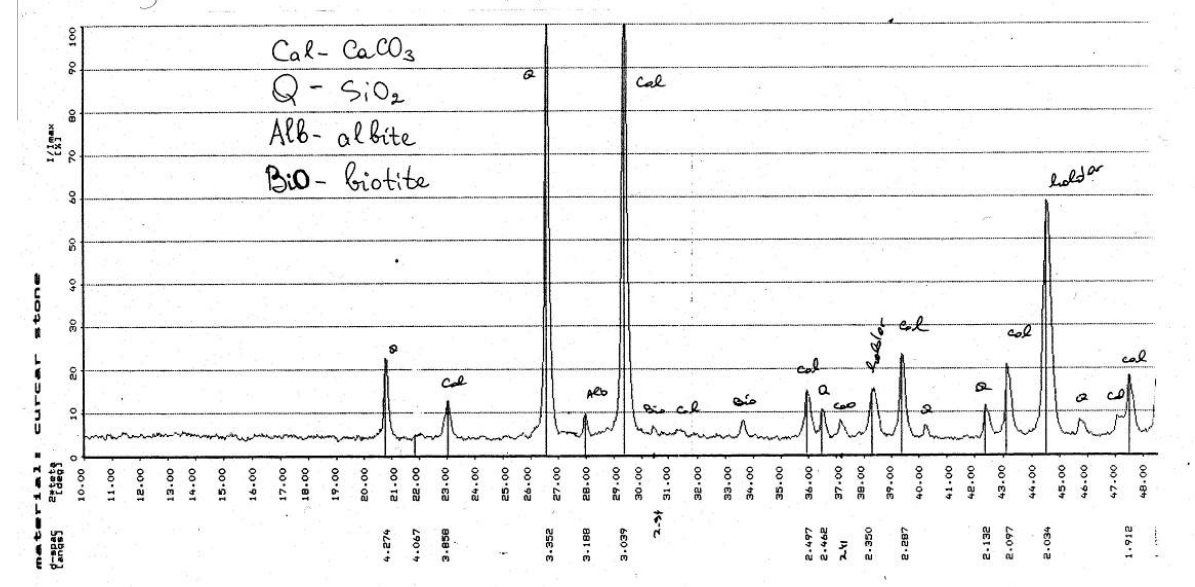
Figure 11. XRD diffraction of kurkar sandstone.